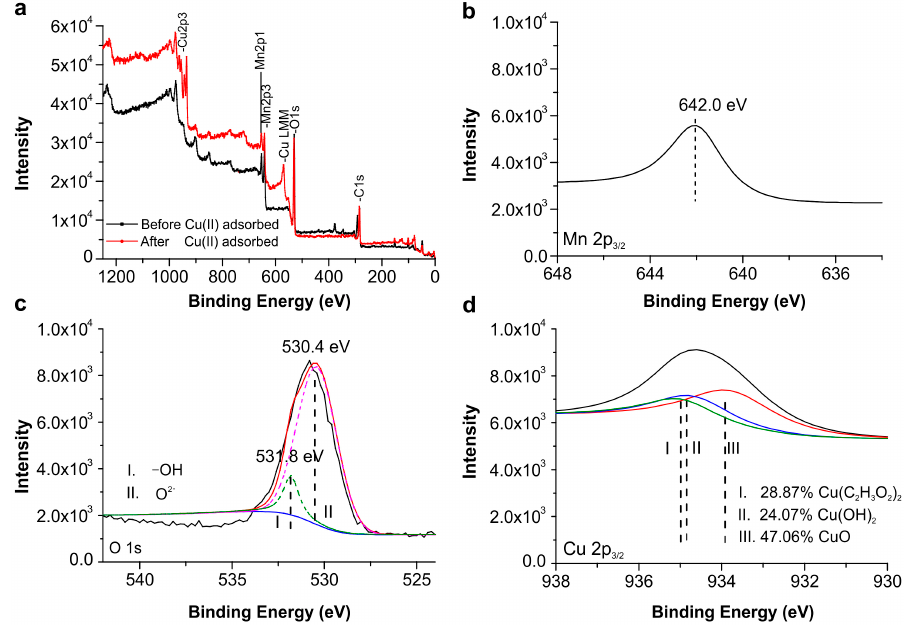
Figure 7. XPS spectra of NMBCs ( a ) survey spectra of NMBCs before and after Cu(II) adsorption; ( b ) Mn 2p 3/2 ; ( c ) O 1s spectra of NMBCs before Cu(II) adsorption, the blue line is the baseline and red line is total O 1s; and ( d ) Cu 2p 3/2 spectrum of NMBCs after Cu(II) adsorption.